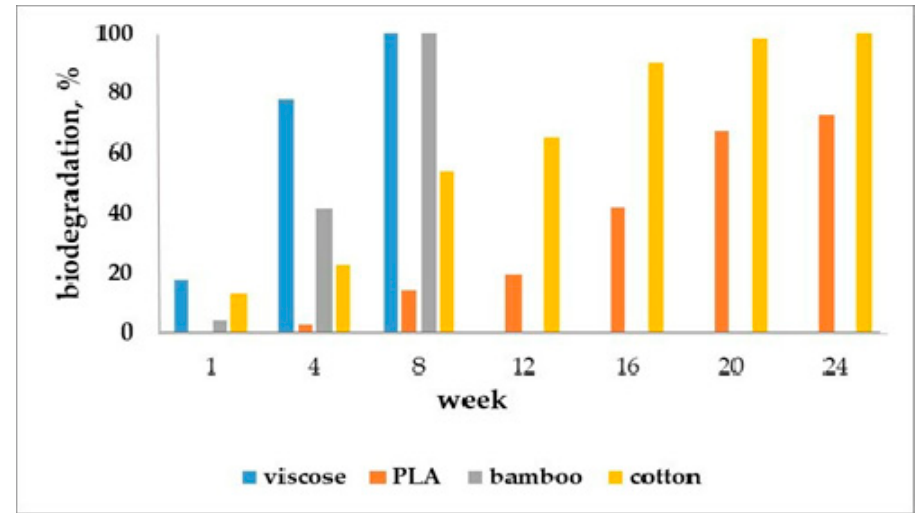
Figure 4. Comparison of biodegradation progress of tested nonwovens.